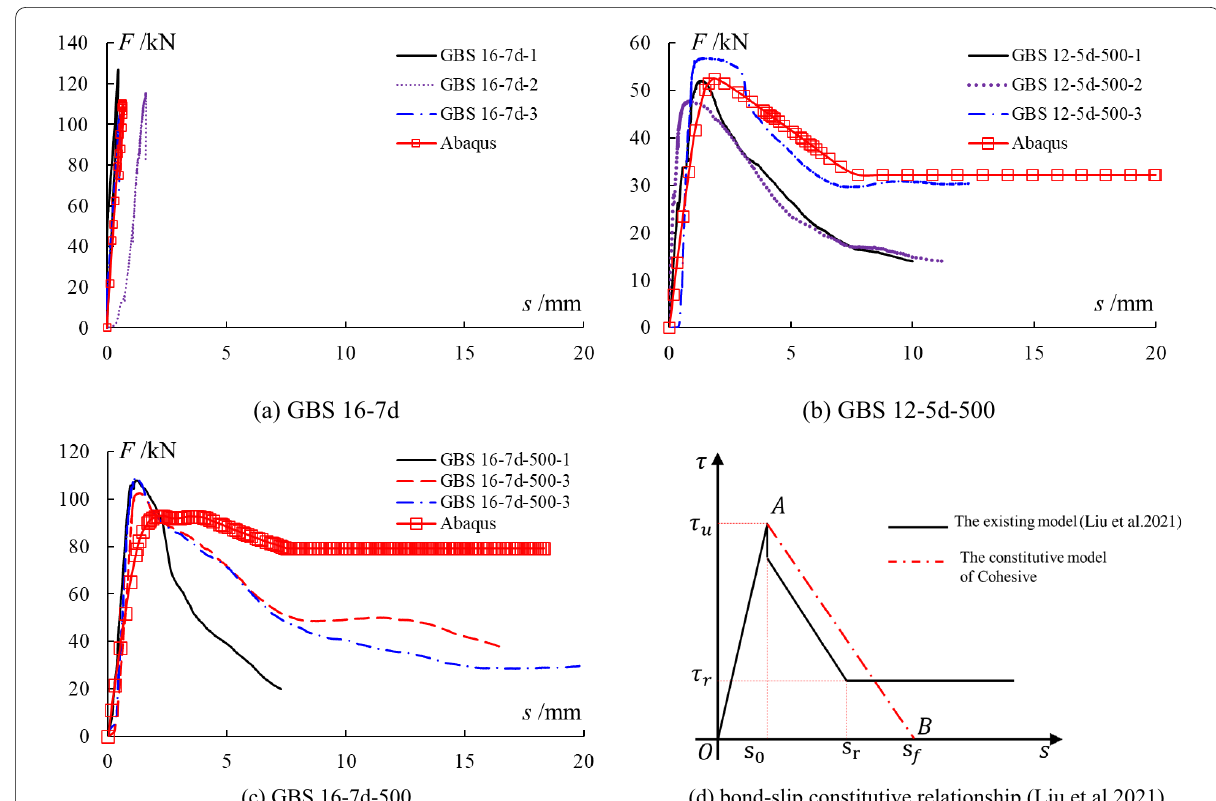
Fig. 8 Load versus slip curves and bond‑slip constitutive relationship.